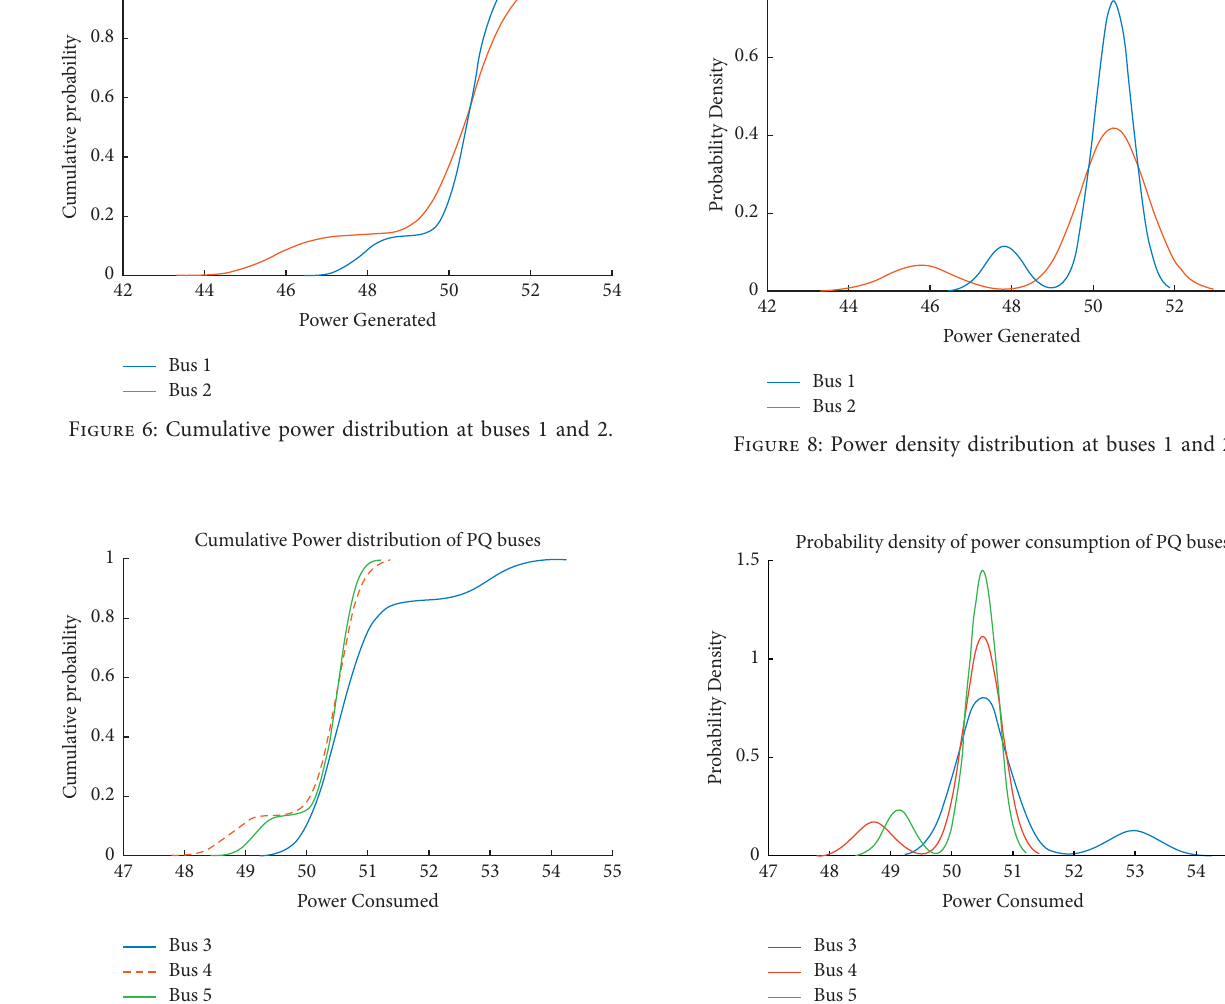
Figure 7: Cumulative power distribution at buses 3–5.